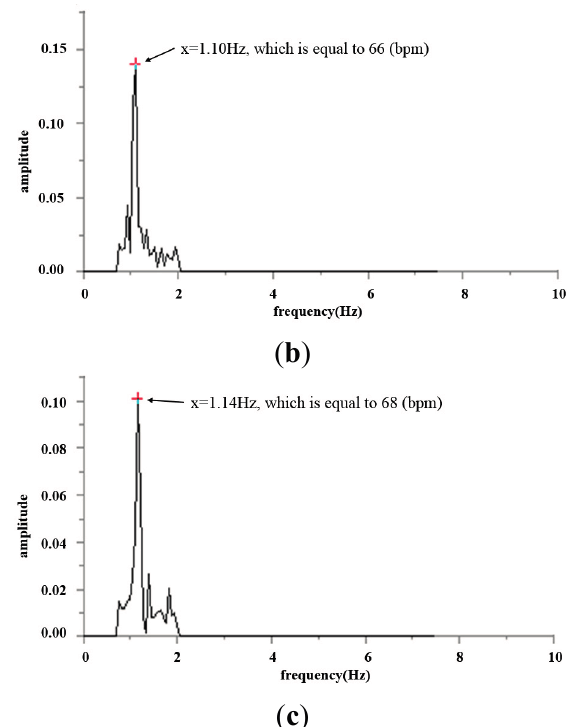
Figure 18. Heart beat frequency graph (frequency–amplitude) for cun, guan and chi pulses. ( a ) Heartbeat frequency graph (frequency–amplitude) for the cun pulse; ( b ) Heart beat frequency graph (frequency–amplitude) for guan pulse; ( c ) Heart beat frequency graph (frequency–amplitude) for chi